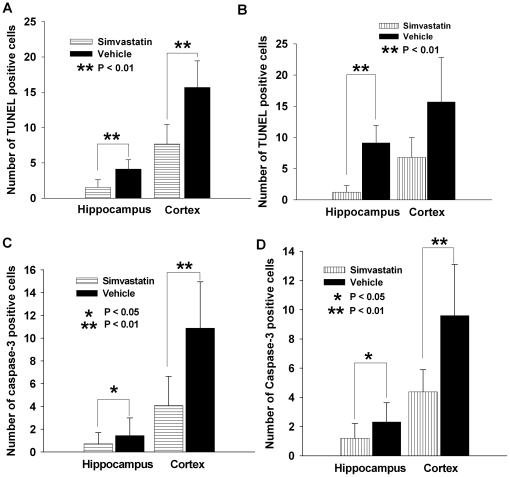
Quantification of TUNEL and caspase-3/NeuN positive cells in cerebral cortex and hippocampus.Pre-treatment of simvastatin significantly reduces the number of both TUNEL (A, P<0.01 for both cortex and hippocampus regions) and caspase-3/NeuN positive cells (C, P<0.05 in hippocampus, P<0.01 in cortex) as compared to vehicle treatment. Similarly, post-treatment of simvastatin significantly reduces the number of both TUNEL (B) and caspase-3/NeuN positive cells (D) in brain area of hippocampus (P<0.01 for TUNEL, P<0.05 for caspase-3/NeuN staining). However, in cerebral cortex, post-treatment with simvastatin only markedly reduced the number of caspase-3/NeuN positive cells (D, P<0.01) but not TUNEL positive cells (B, P>0.05). All data are mean ± SD.